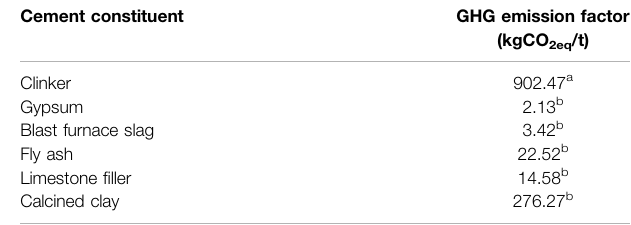
TABLE 3 | GHG emission factors of the cement